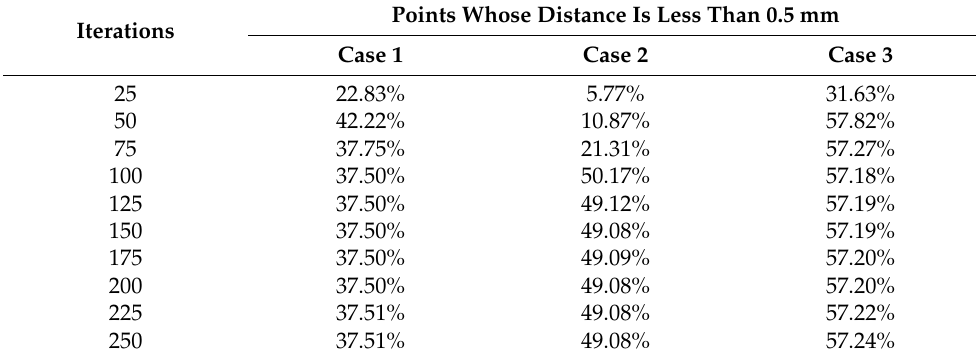
Table 2. Result of accuracy comparison with different iterations.